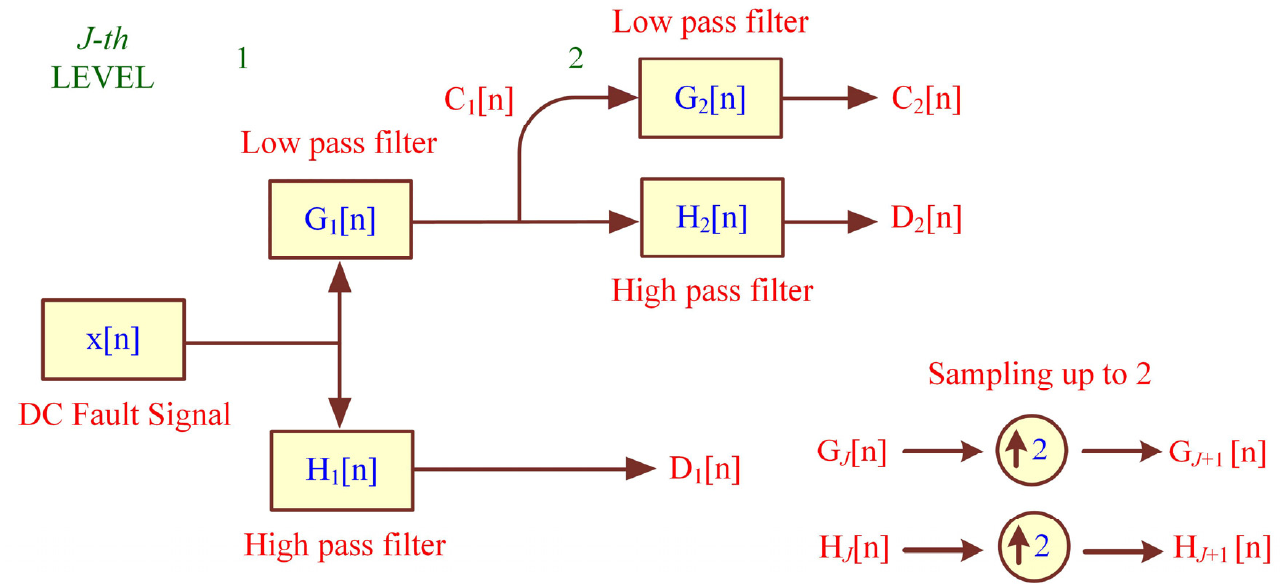
Figure 5. Illustrating the SWT algorithm in its simplest form. The SWT provides a multi-resolution representation of the signal, allowing for better analysis and detection of specific features in the signal, such as DC faults. While decompos- ing DC fault signals x[n], H J [ n ] high pass and low pass filters G J [ n ] were used at J - th level, C J [ n ] and D J [ n ] represent approximation and detail coefficients at J - th level. A high pass H J [ n ] and low pass G J [ n ] filter was obtained by up-sampling the filters from the previous level ( J − 1) and convolving them with the approximation coefficient at that level ( J − 1) to extract decomposition at level J . At this level, you will be able to obtain detail and approximation coefficients. Decomposition was performed iteratively until the desired number of levels is reached. A detailed coefficient for each level of decomposition J was calculated using (3).